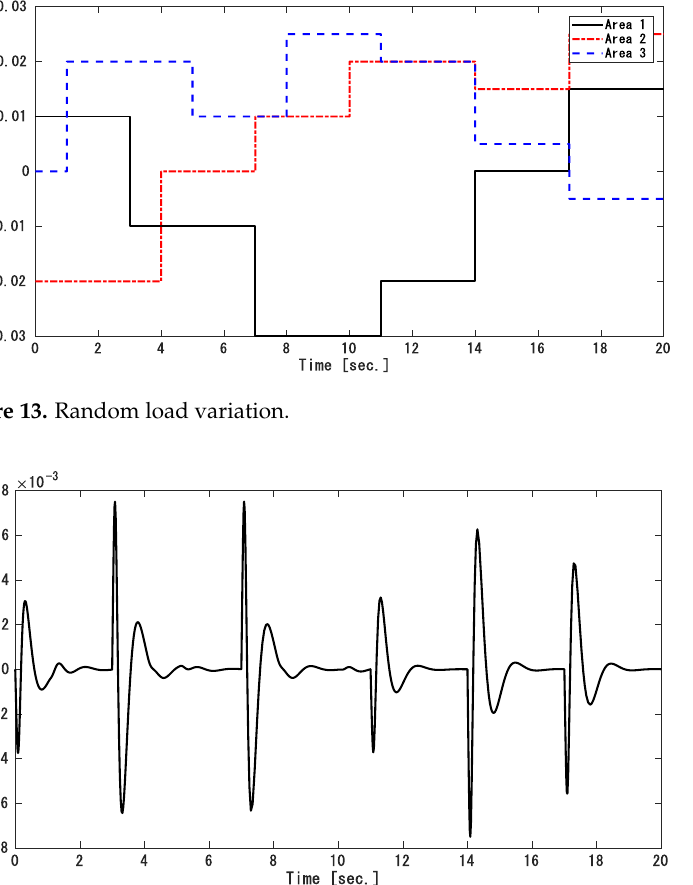
Figure 14. The frequency variation of 1st area.